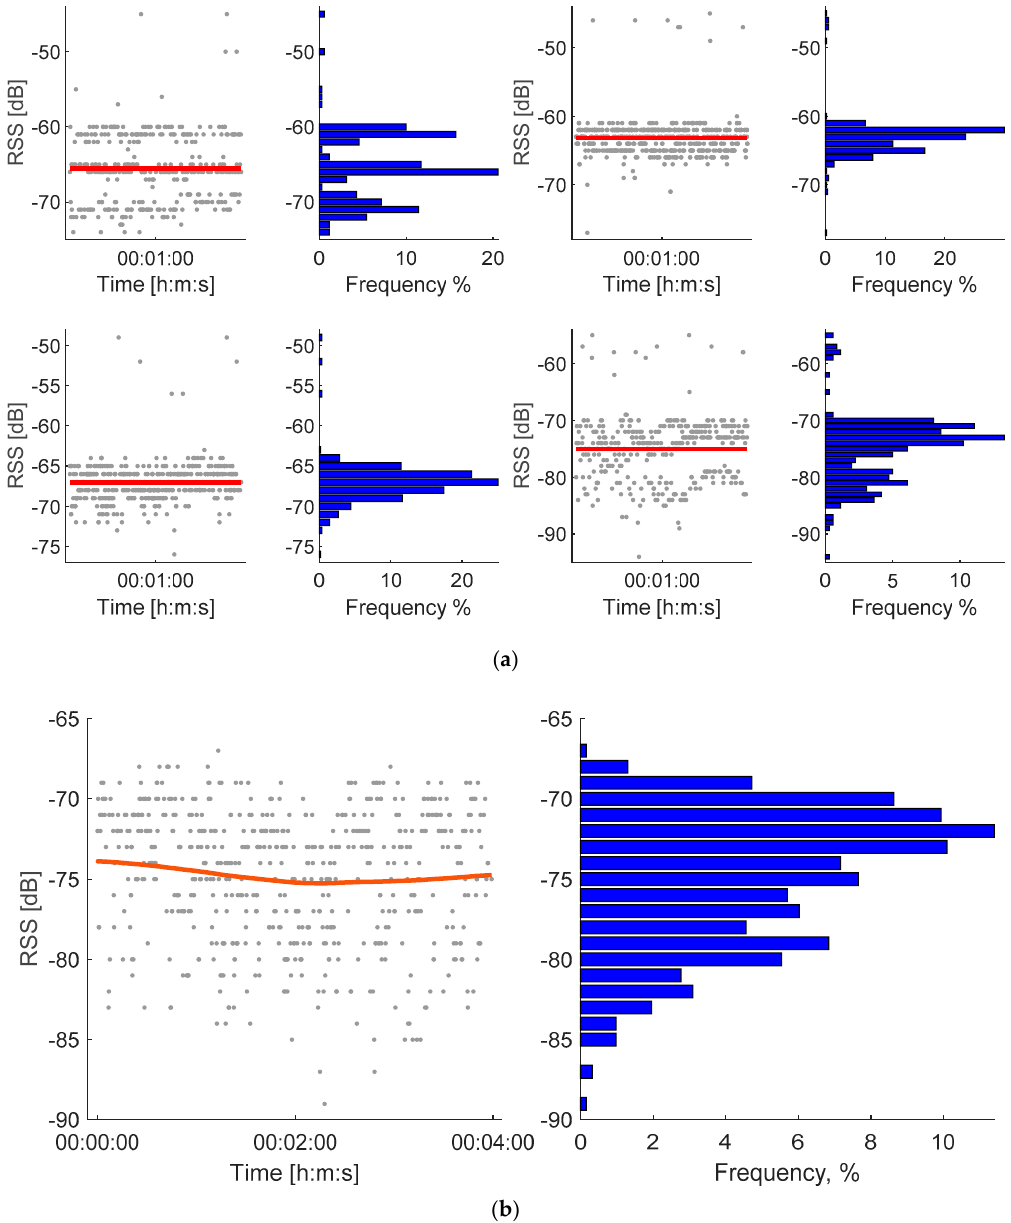
Figure 5. Typical received signal strength (RSS) during the measurement time and its frequency distribution in histogram for the open-space environment ( a ) and the barn environment ( b ). The distances between the tag and the receiving stations were 5, 10, 15 and 20 m accordingly in the open space (a) and 10 m in the barn (b). The signal was averaged similar to the RSS propagation experiment ( a ) and filtered similar to the actual RSS measuring in barn ( b ).